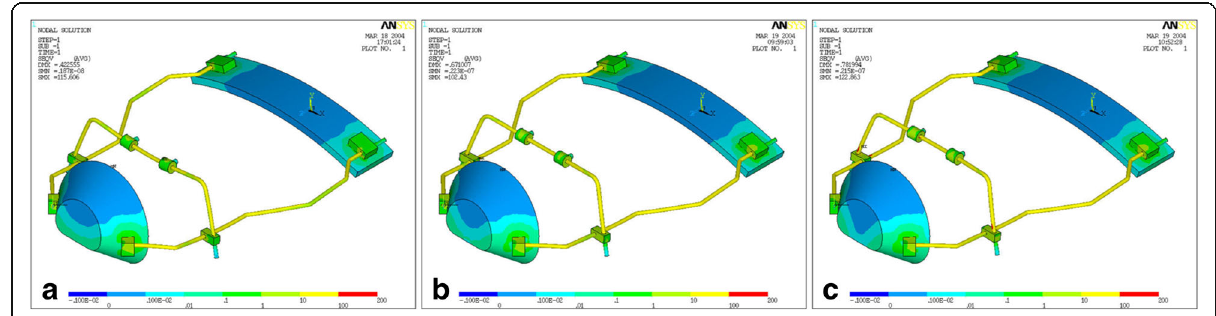
Fig. 4 Stress distribution with traction load of 7.8 Newton applied on FM model. The force direction was progressively inclined to the occlusal plane of 0° ( a ), 30° ( b ), and 50° ( c